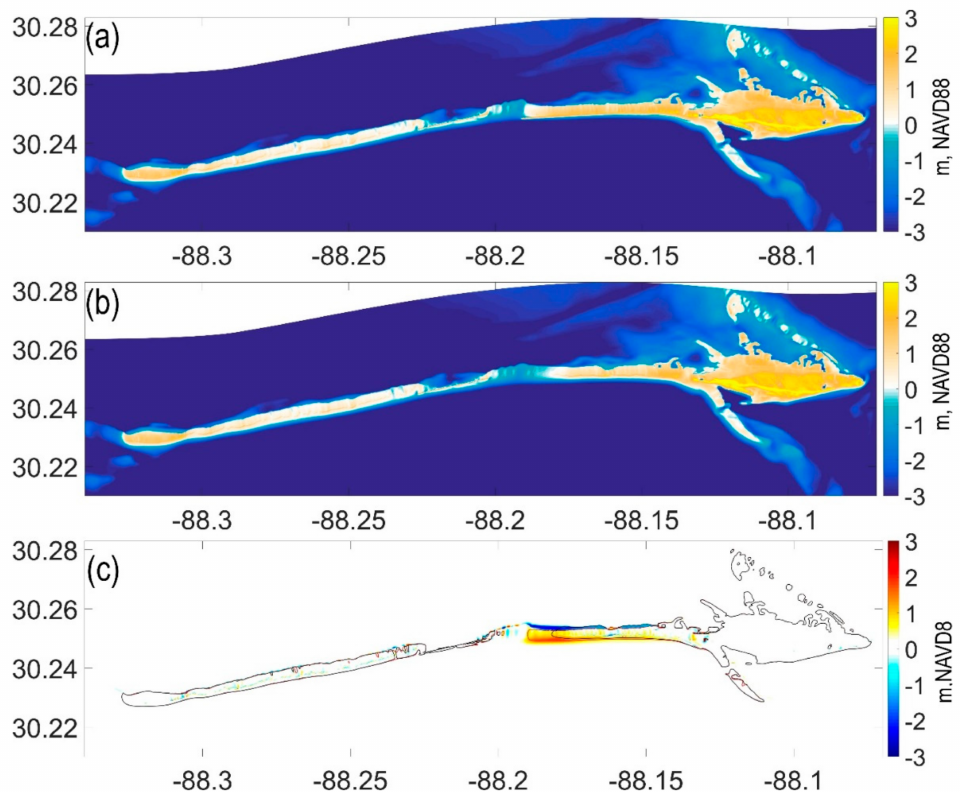
Figure 2. Modeled bed level elevations for ( a ) final (Year 30) nourishment scenario, ( b ) final (Year 30) no-action scenario and ( c ) difference between final nourishment scenario and no-action. In ( c ), the black line is the 0 m contour for final (Year 30) no-action scenario and the red line is the 0 m contour for the final (Year 30) nourishment